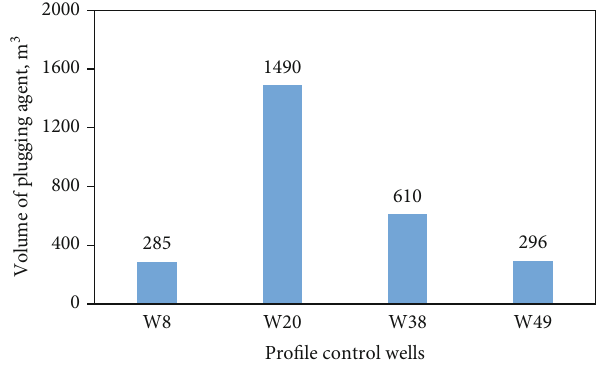
Figure 14: Required plugging agent volume for each pro fi le control